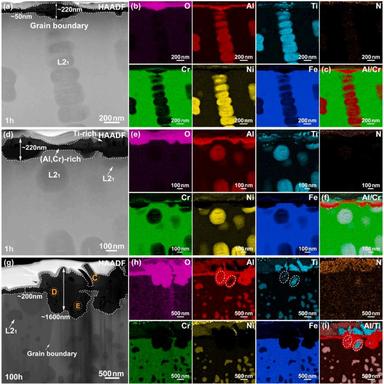
The HAADF and STEM-EDS analysis of the cross-section oxide scale of Al12 CCA after 1 h and 100 h oxidation at 800 ◦C in air. (a) HAADF image, (b) EDS mappings; (c) EDS mapping superposition of Al and Cr elements, at the grain boundary; (d) HAADF image, (e) EDS mappings, (f) EDS mapping superposition of Al and Cr elements, within the grain, after 1 h oxidation; (g) HAADF image, (h) EDS mappings, (i) EDS mapping superposition of Al and Ti elements, after 100 h oxidation.